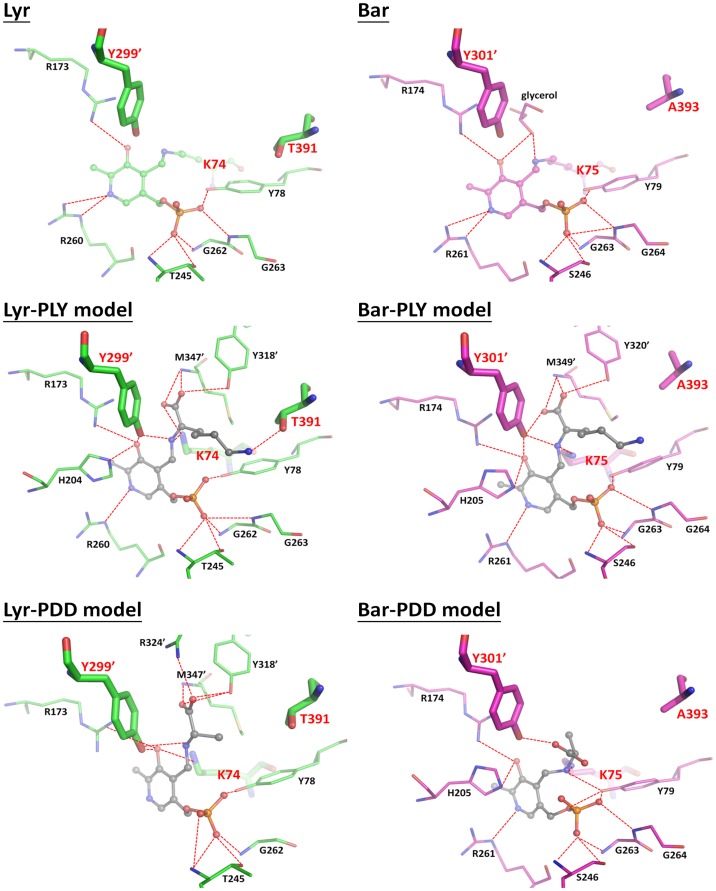
Protein-ligand interactions in crystal structures and docked models (See also Figure S4 and Table S2, S3, S4, S5).Residues of Lyr and Bar are colored green and magenta, respectively. The docked substrates presented as the external aldimine form inside Lyr and Bar are colored gray. The hydrogen bonding is labeled by red dashed lines. Oxygen, nitrogen, and phosphate atoms are colored red, blue, and orange, respectively.